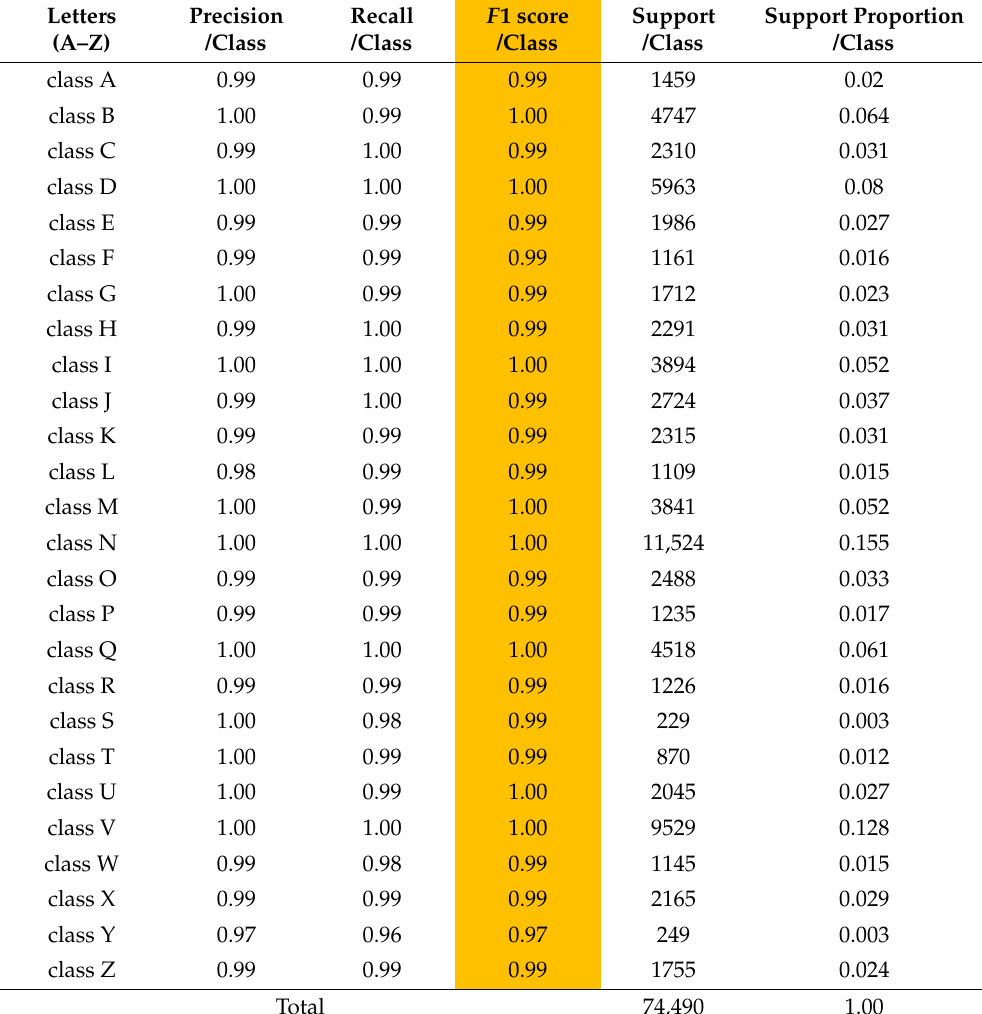
Table 4. Classification report of model K5 for A–Z